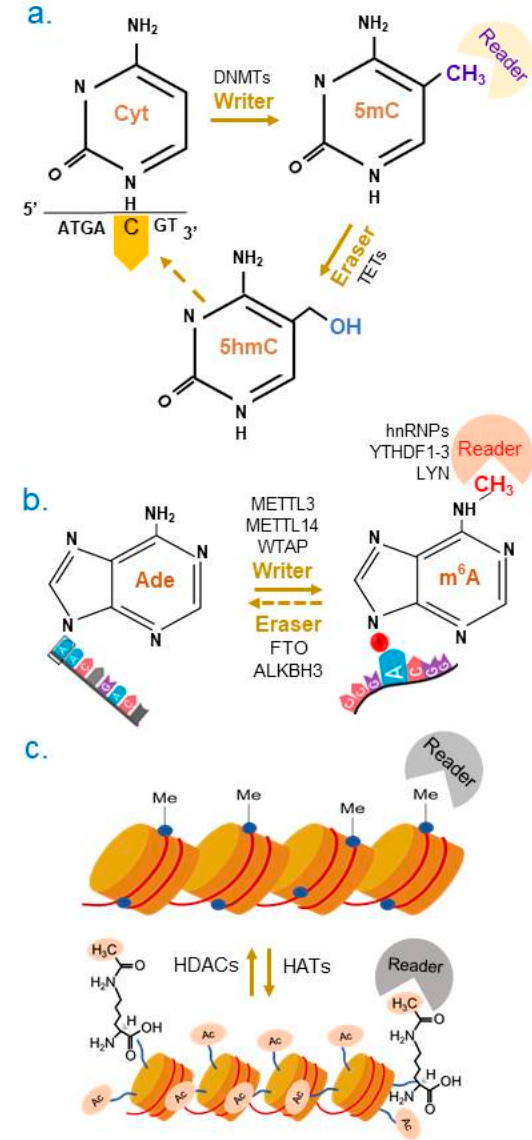
Figure 4. Modules of chemical modifications on cytosine, adenosine, and lysine residues. ( a ) Illustrations showing the DNA methylation at the fifth residue in cytosine (5mC) by DNMTs and demethylation by oxidation of 5mC into 5-hydroxymethylcytosine (5hmC) by TETs, and recycling back to cytosine. ( b ) Illustrations showing the modulation of RNA methylation and demethylation at the sixth position in adenosine, N6-methyladenosine (m 6 A) by writers and erasers, respectively, and recognition of modified base by readers. ( c ) Illustrations showing histone acetylation on ε -N-acetyl lysine and deacetylation by HATs and HDACs, respectively, and recognition of modified base by readers. Ac, acetylation; Me, methylation. Refer to the main test for details.